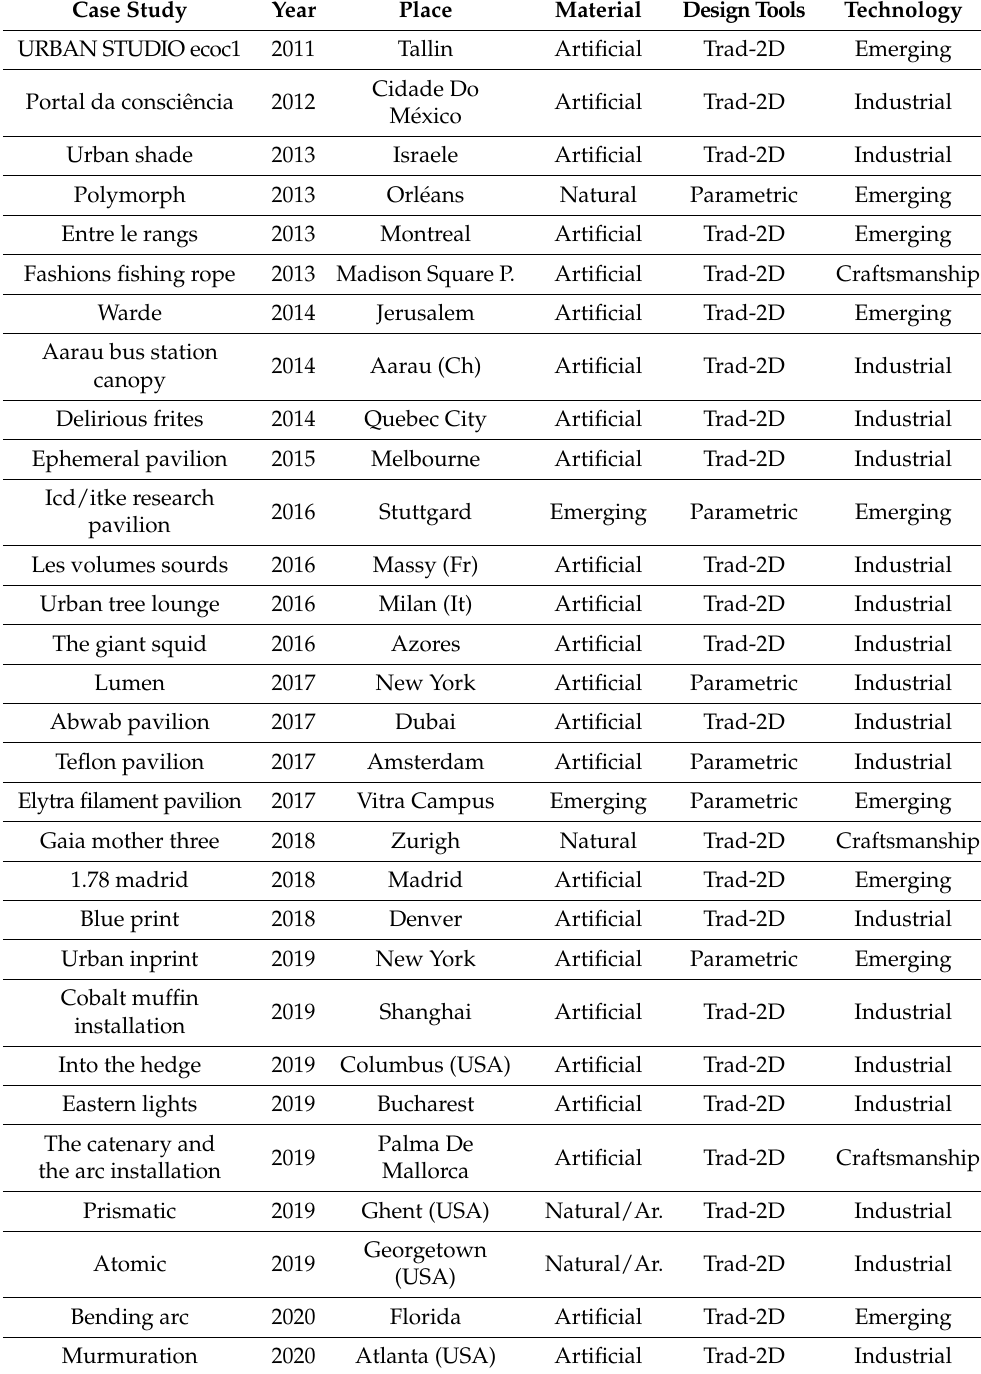
Table 1. Case studies of urban installations made with textile fibers (natural-artificial-digital/emerging) and different technologies (craftsmanship, digital/emerging, industrial)